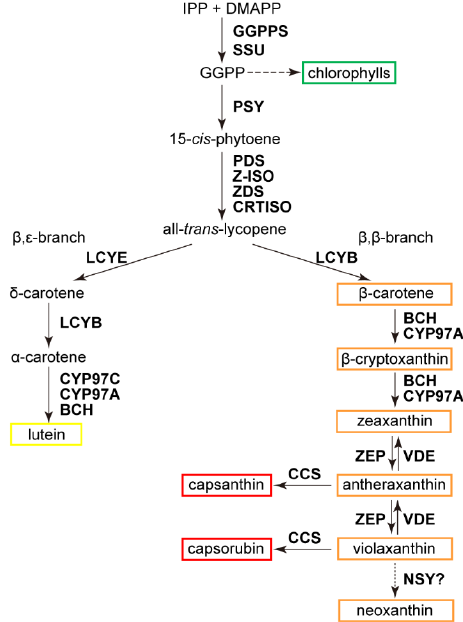
Figure 1. Carotenoid biosynthetic pathway. Enzymes are in bold face. Abbreviations for enzymes and substrates are: BCH, β -carotene hydroxylase; CCS, capsanthin/capsorubin synthase; CRTISO, carotene isomerase; CYP, cytochrome P450; DMAPP, dimethylallyl diphosphate; GGPP, geranylgeranyl diphosphate; GGPPS, GGPP synthase; IPP, isopentenyl diphosphate; LCYB, lycopene β -cyclase; LCYE, lycopene ε -cyclase; NSY, neoxanthin synthase; PDS, phytoene desaturase; PSY, phytoene synthase; VDE, violaxanthin de-epoxidase; ZEP, zeaxanthin epoxidase; ZDS, ζ -carotene desaturase; and Z-ISO, ζ -carotene isomerase. Pigments analyzed in this study are indicated: the β , β -branch and β , ε -branch carotenoids are boxed in yellow and orange, respectively; capsanthin and capsorubin are boxed in red; and chlorophylls are boxed in green. Question mark and dashed arrow indicate that the conversion of violaxanthin to neoxanthin in chili pepper was catalyzed by a presumed NSY.